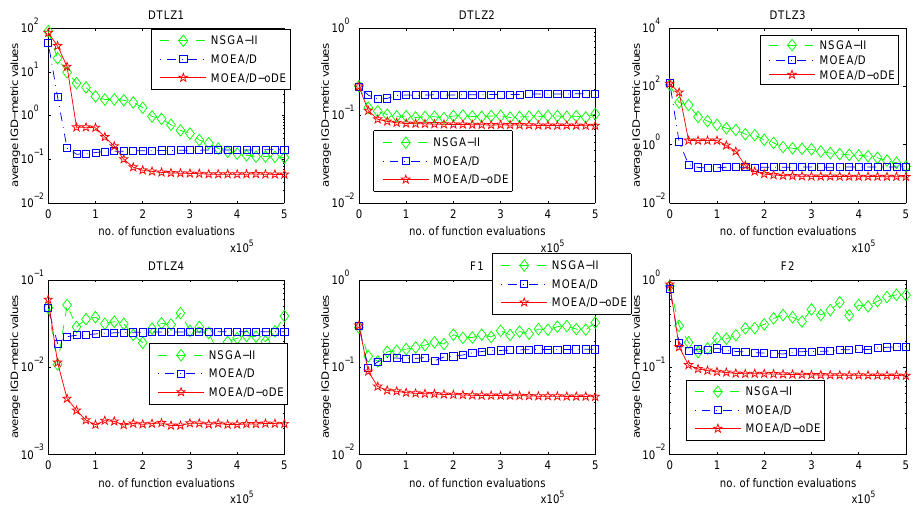
Figure 4. Evolution of the mean of IGD metric values for five-objective test